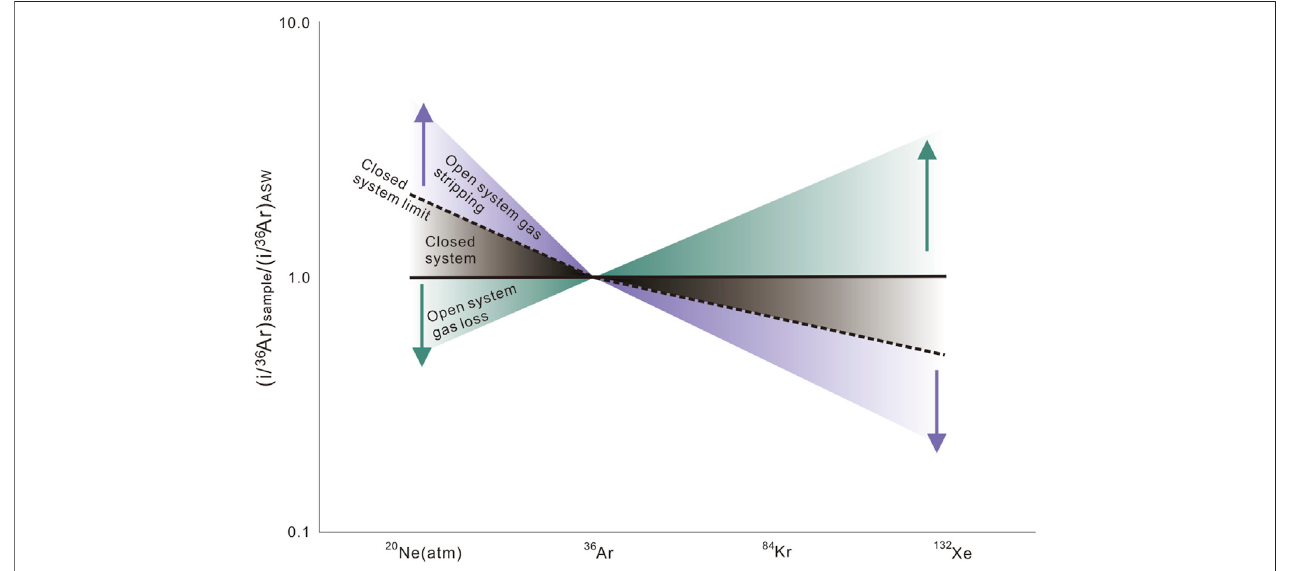
FIGURE 6 | (i/ 36 Ar) sample vs. (i/ 36 Ar) ASW plot for 20 Ne (atm), 84 Kr, and 132 Xe showing the expected noble gas ratios under different theoretical conditions (modi fi ed from Bosch and Mazor, (1988); Karolyt ė , (2019)).